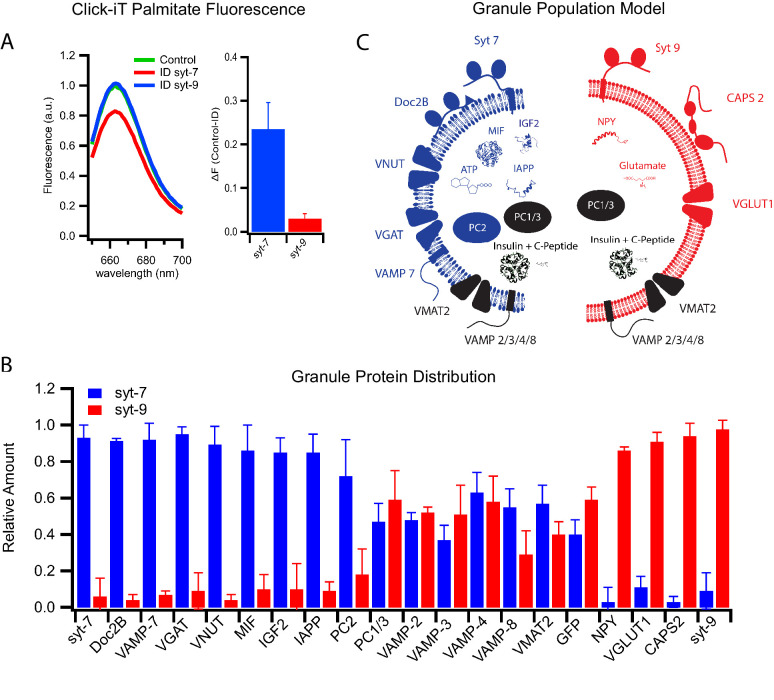
Differential protein distribution into syt7 and syt9 granule subpopulations.(A) Palmitic acid incorporates more efficiently into INS 832/13 cell-derived syt7 than into syt9 granules. Fluorescence spectra (left) of purified insulin granules with incorporated Click-iT palmitate solubilized in 1% Triton-X and then labeled with Alexa647 (by an Azide-Alkyne Click-iT reaction). The spectra are those of granules before (green) and after immunodepletion with syt antibodies (red, depletion using anti-syt7; blue, depletion using anti-syt9). Quantification of fluorescence change in control and syt7 or syt9 granules (right). The results are from three separate purifications of insulin granules. (B) Distribution of granule proteins between syt7 and syt9 granules that were derived from GRINCH cells. Data show the fraction of the total of each protein associated with syt7 (blue) vs syt9 (red) granules as determined from quantitative western blotting (Figure 5—figure supplement 1); error bars are standard deviation from three independent samples. For statistics see Figure 5—source data 1. (C) Model summarizing the compositions of syt7 (blue) and syt9 (red) insulin granules.Figure 5—source data 1.Significance values of protein contents between different immunodepleted granules obtained from Figure 5B and Figure 5—figure supplement 1.